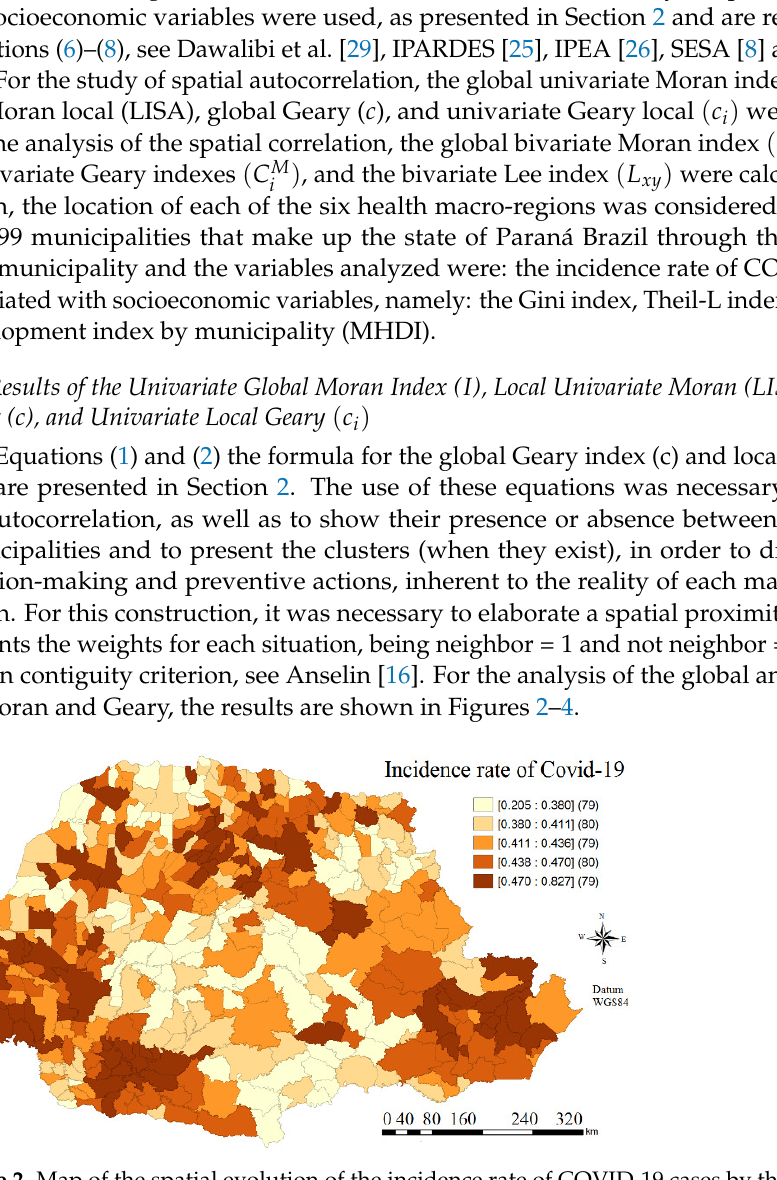
Figure 2. Map of the spatial evolution of the incidence rate of COVID-19 cases by the municipality, stratified by quantile intervals, referring to June to December